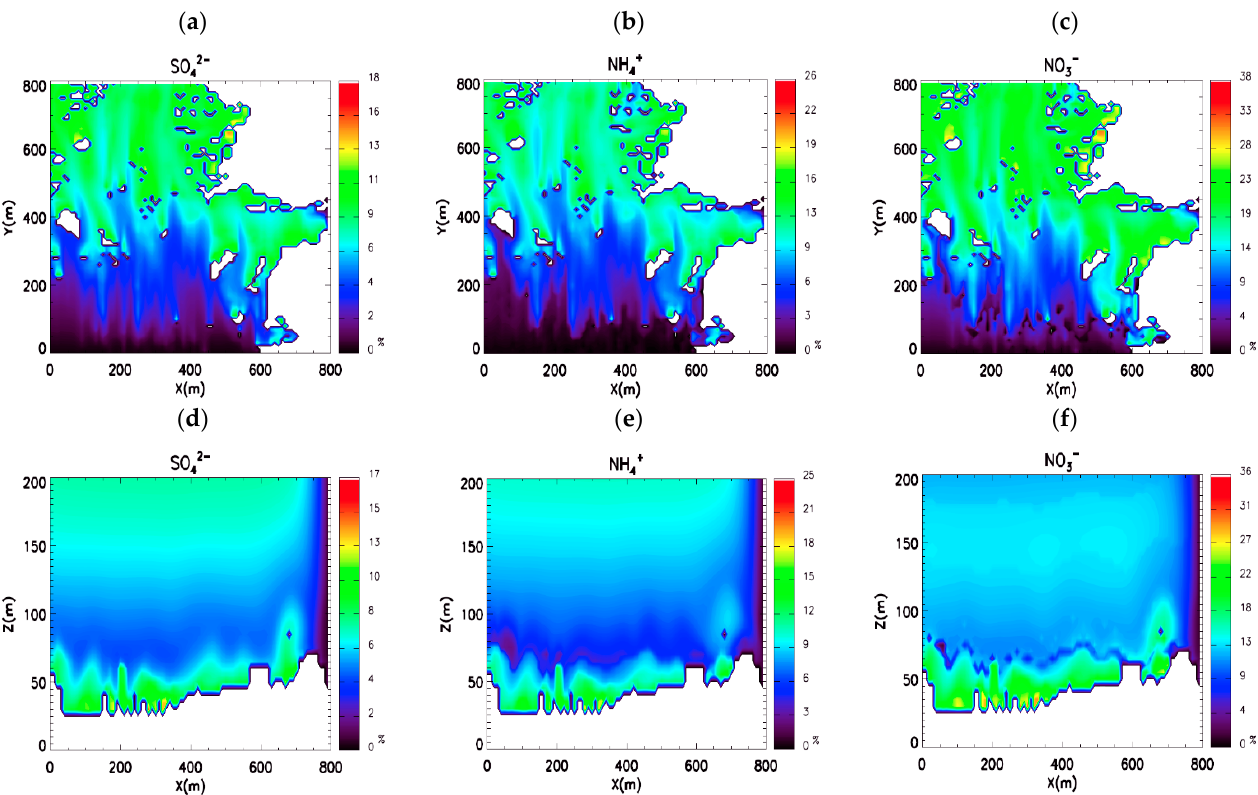
Figure 8. Reduction rate (%) of secondary inorganic aerosol (SIA) concentration owing to washout processes. Reduction rate of ( a ) sulfate, ( b ) ammonium, and ( c ) nitrate at the surface. Meridionally averaged reduction rate of ( d ) sulfate, ( e ) ammonium, and ( f ) nitrate in the x - z plane.